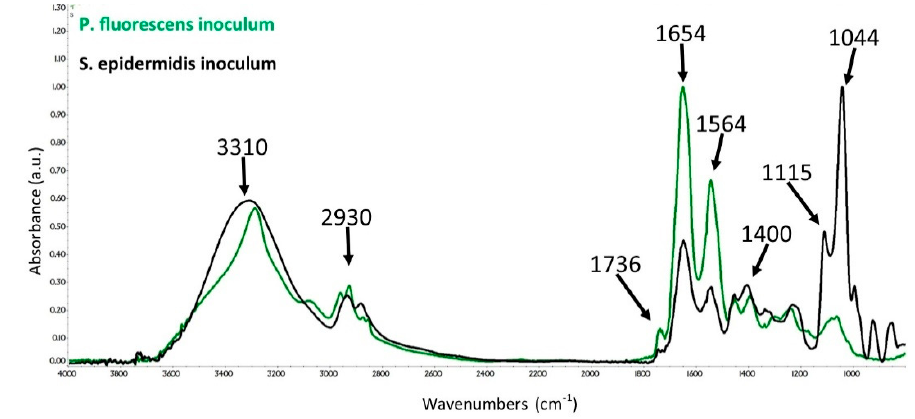
Figure 2. FTIR spectra of P. fluorescens (green) and Staphylococcus epidermidis (black).